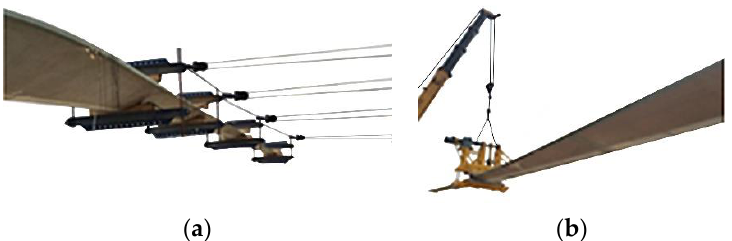
Figure 3. Full-scale static experiments of the wind turbine blade. ( a ) Side pulling in the full-scale static experiment of the wind turbine blade; ( b ) Lifting in the full-scale static experiment of the wind turbine blade.